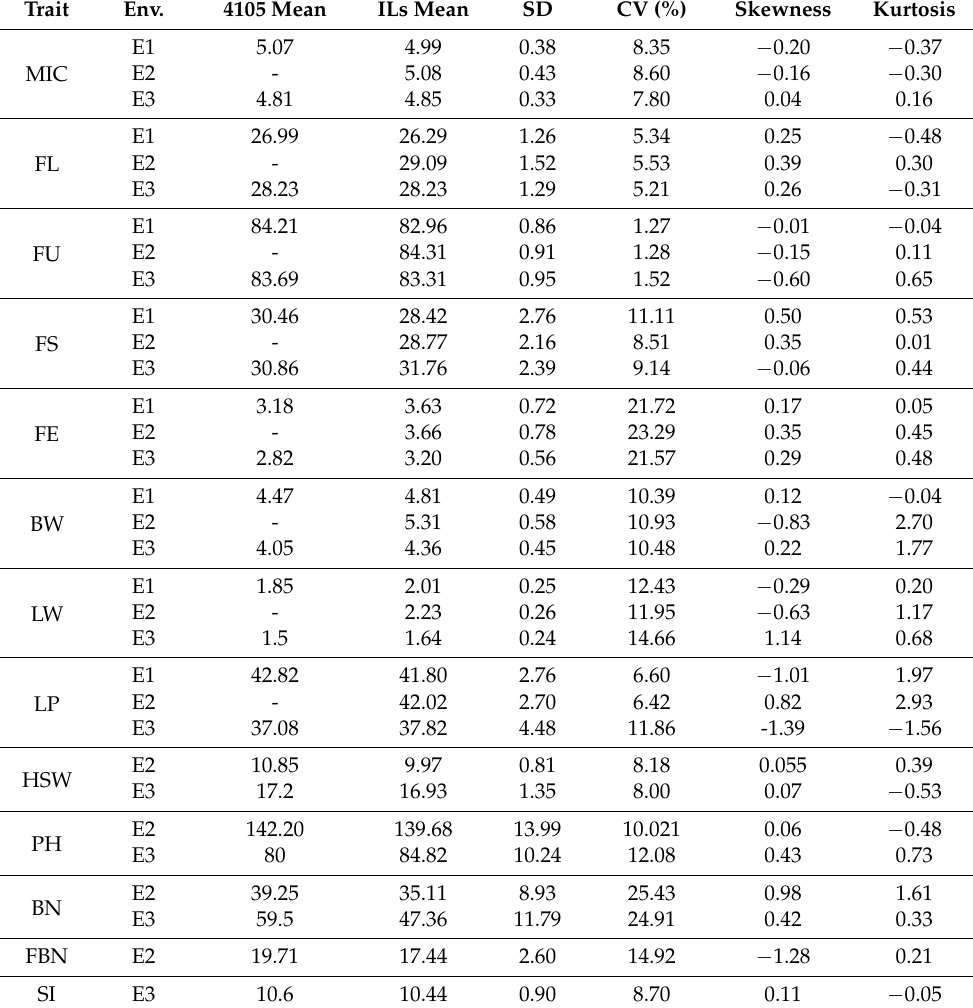
Table 2. Descriptive statistics of values for various fiber quality and yield traits across three environments. Trait